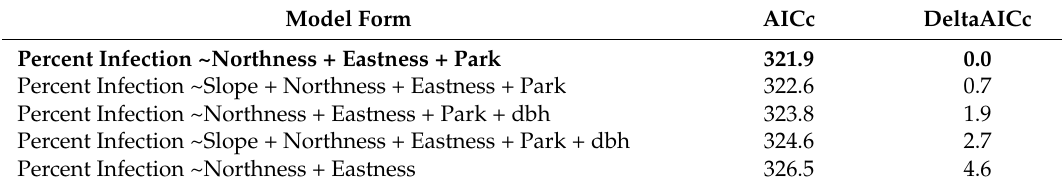
Table 4. Relative rating for top five linear mixed effect models for predicting percent live infected trees; the selected best model is in bold . All models contain a random site effect. DeltaAICc is the difference in AICc from the top